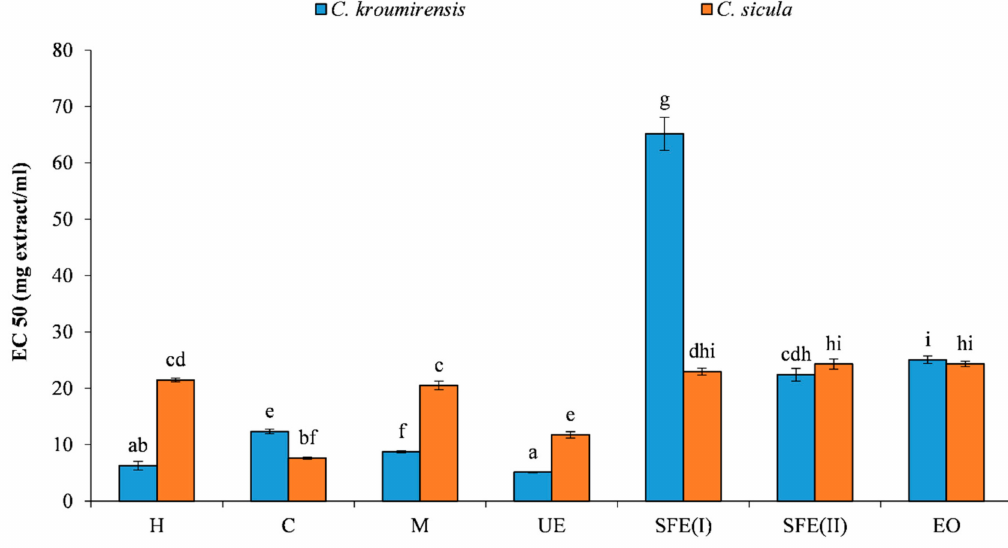
Figure 3. Reducing power (EC 50 , mg / mL) determined in extracts obtained from aerial part of two Centaurea species ( C. kroumerienis and C. sicula ) with di ff erent extraction techniques (Di ff erent letters indicate significant di ff erence ( p <